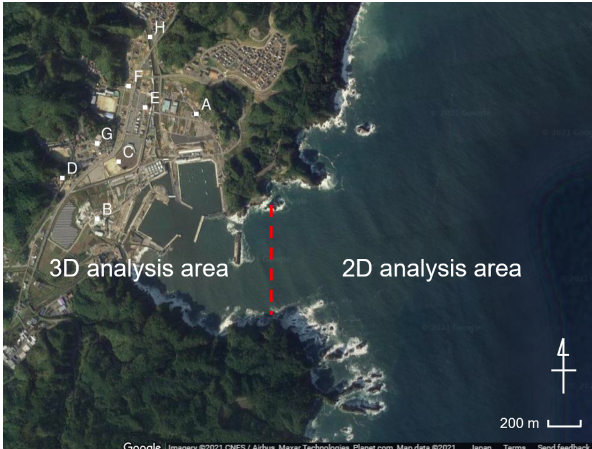
Figure 6. Boundary between the 2D analysis and 3D analysis areas. Points A to H are used to compare the inundation depths between observational data and simulation results (© Google